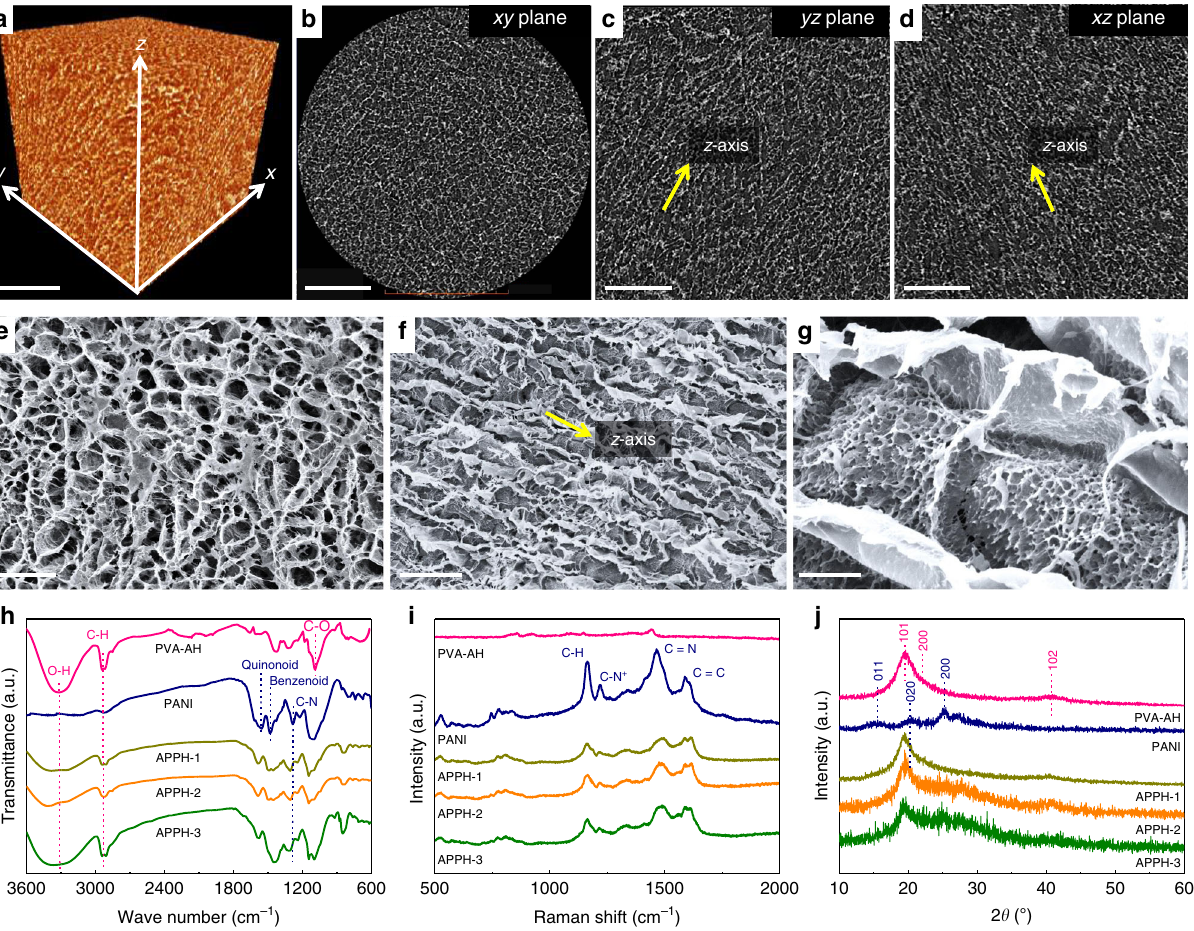
Fig. 2 Structural and compositional characterization. a Volume rendering of the anisotropic polyvinyl alcohol/polyaniline hydrogel-2 (APPH-2) derived from X-ray computed microtomography (microCT) images, and microCT images display b xy , c yz, and d xz plane, respectively. Scale bars: a – d 100 μ m, respectively. Scanning electron microscopy (SEM) images of the APPH-2 from view of e perpendicular and f , g parallel to z -axis. Scale bars: e , f 20 μ m, respectively; g 2 μ m. Yellow arrow in f indicating the z -axis. h Fourier transform infrared spectra (FTIR), i Raman spectra and j X-ray diffraction